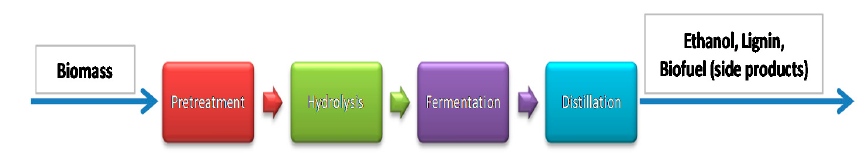
Figure 3. A simplified block flow diagram of the fermentation process.